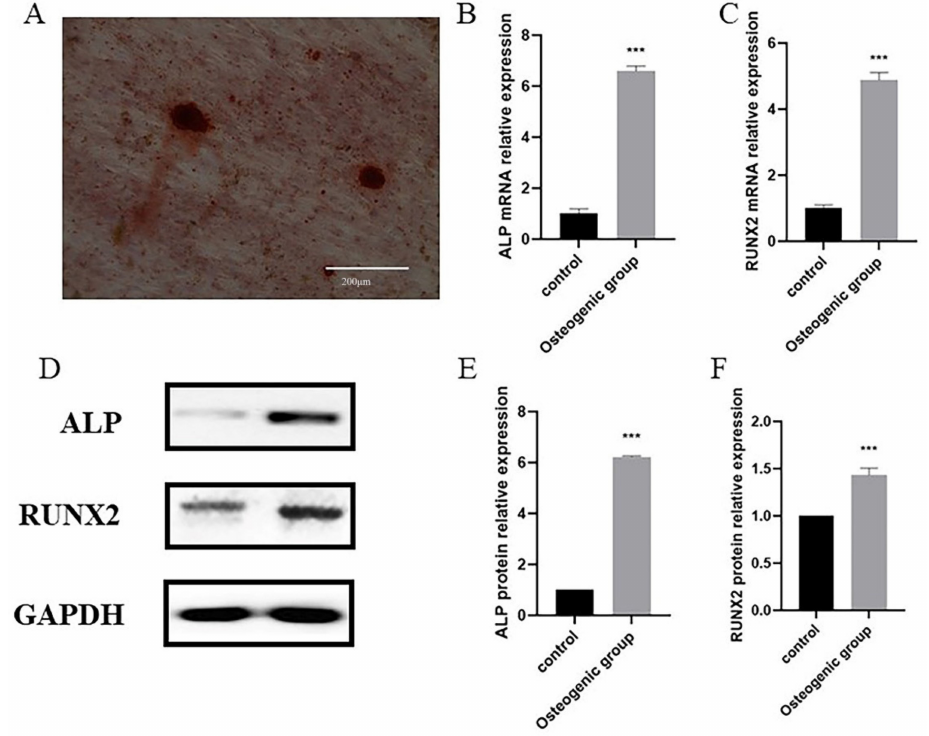
Figure 12. ( A ) The osteogenic induced of ADSCs to differentiate into osteoblasts confirmed by Alizarin Red S. ( B , C ) The expression of ALP ( B ) and RUNX2 ( C ) quantified by qPCR in the unin- duced and the osteogenic induced of ADSCs. ( D ) The expression of the ALP and RUNX2 ana- lyzed by Western blot. ( E , F ) Relative intensity analyses of Western blot results of ALP ( E ), RUNX2 ( F ). p < 0.001